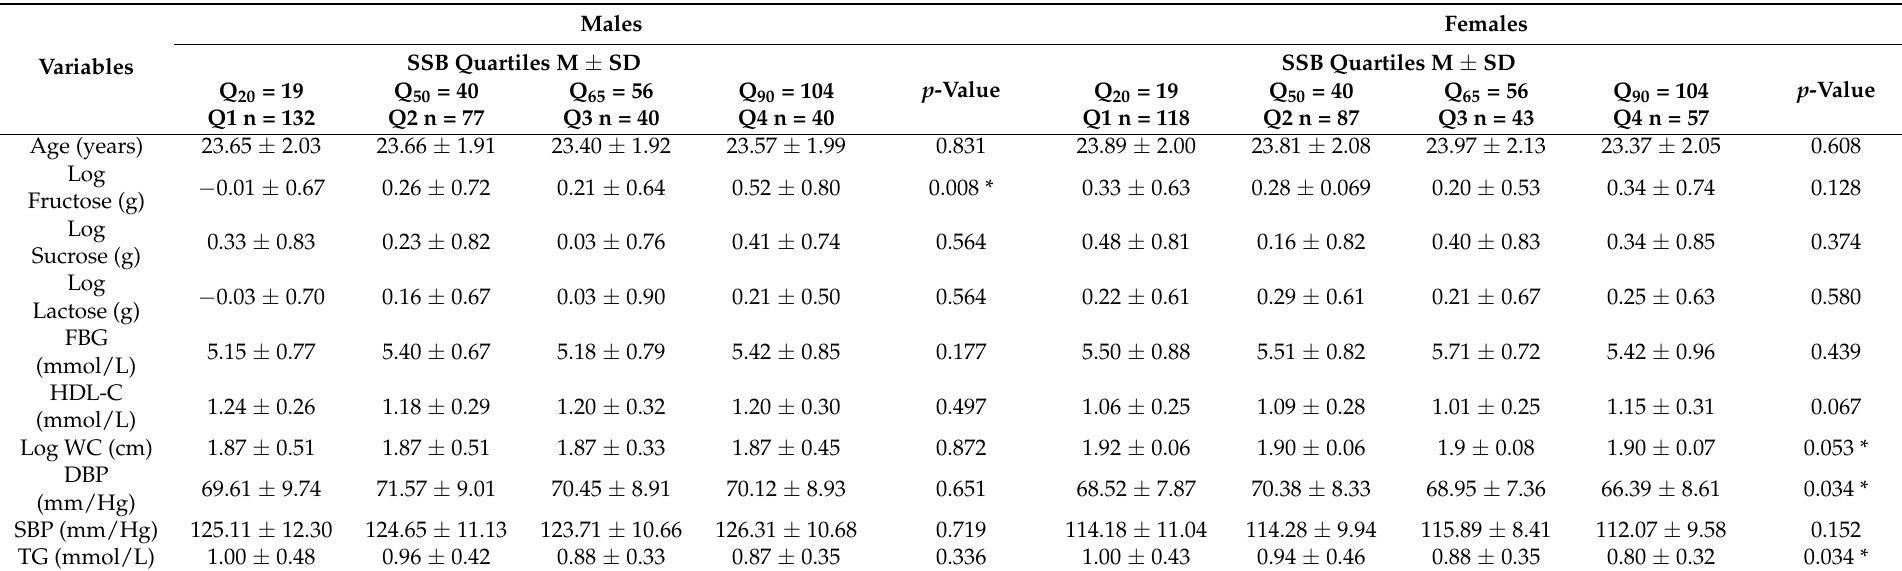
Table 1. The participant’s characteristics (n = 596) of Ellisras young rural adults aged 22–30 years, stratified by SSBs